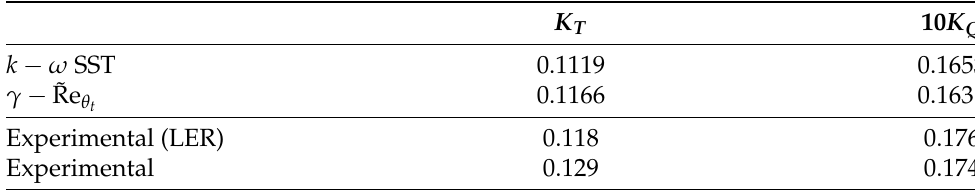
Table 9. Propeller force predictions at Re = 5 × 10 5 for J = 0.568. Comparison with experimental results [49]. Reproduced with permission from